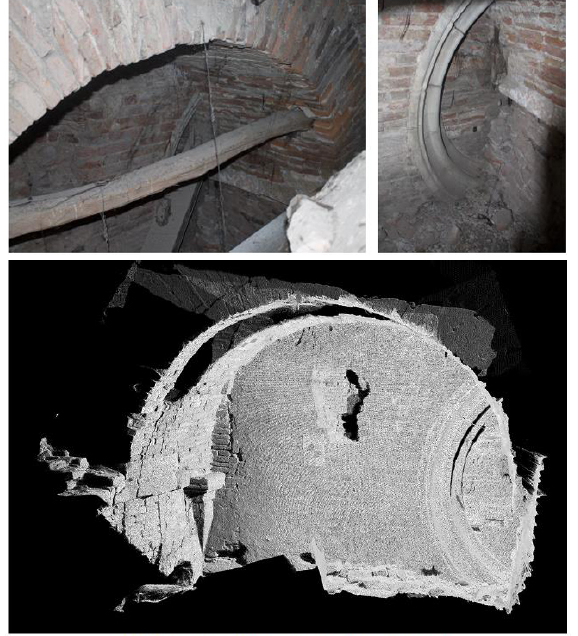
Figure 4. Photos and pointcloud representing the indoor side of the fac¸ade wall in the extreme eastern attic. Top left: photo of a big arch in the fac¸ade wall, over the chapel rows, in right attic. Top right: Detail of a closed window in the wall under the arch. Bottom: pointcloud view of the same element of top images.